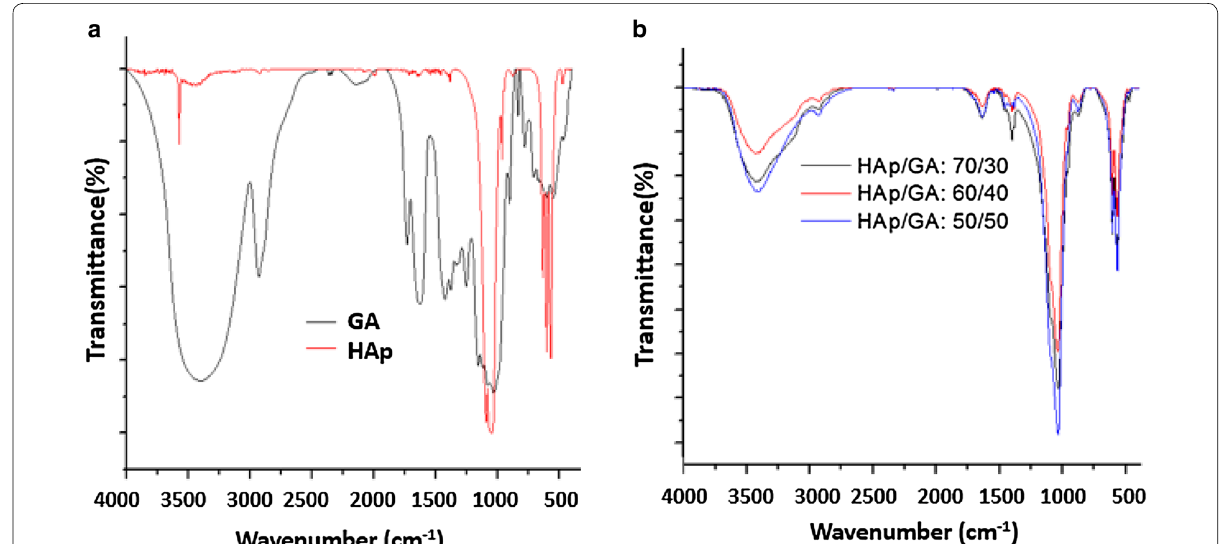
Fig. 2 a FTIR spectra of HAp and Gum Arabic. b The infrared spectra of the HAp/GA